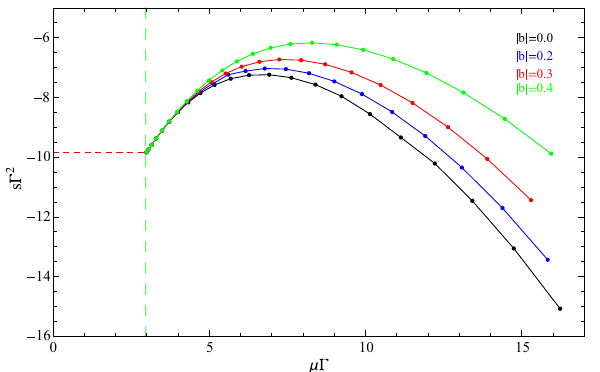
Fig. 3 Theentanglemententropy s asafunctionofthechemicalpoten- tial for different ENE factor b in the half geometry. The red horizon- tal dashed line denotes the entropy in the insulator phase, the green vertical dashed line denotes the critical phase transition point where μ (cid:10) = 2 . 9662 ,and the solid curves denote the entropy in the super- c conductor phase for various ENE factors: black curve for | b | = 0, blue curve for | b | = 0 . 2. Red curve for | b | = 0 . 3 and green curve for | b | = 0 .